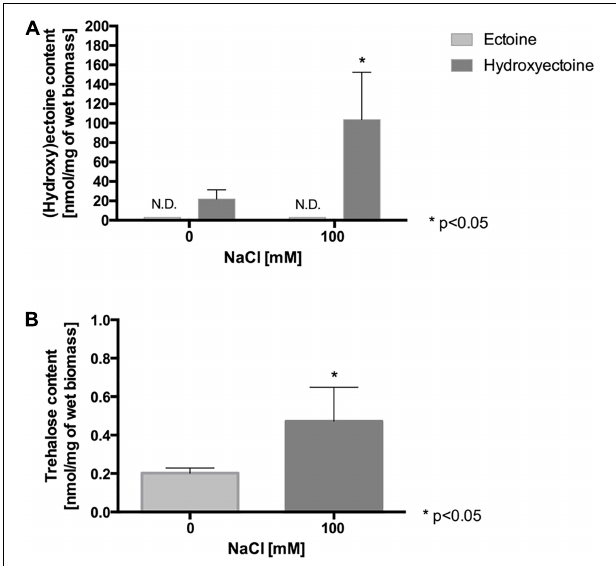
FIGURE 2 | Effect of NaCl exposure on intracellular content of compatible solutes in L. ferriphilum DSM 14647. Content of ectoine and hydroxyectoine (A) , and trehalose (B) in cells exposed to 100 mM NaCl for 90 min. The data represent the average of 3 independent experiments (bars indicate the value range). Statistical analysis was carried out by ANOVA and t -Test. N.D.: not detected. FIGURE 3 | Effect of NaCl exposure on intracellular pH (pH